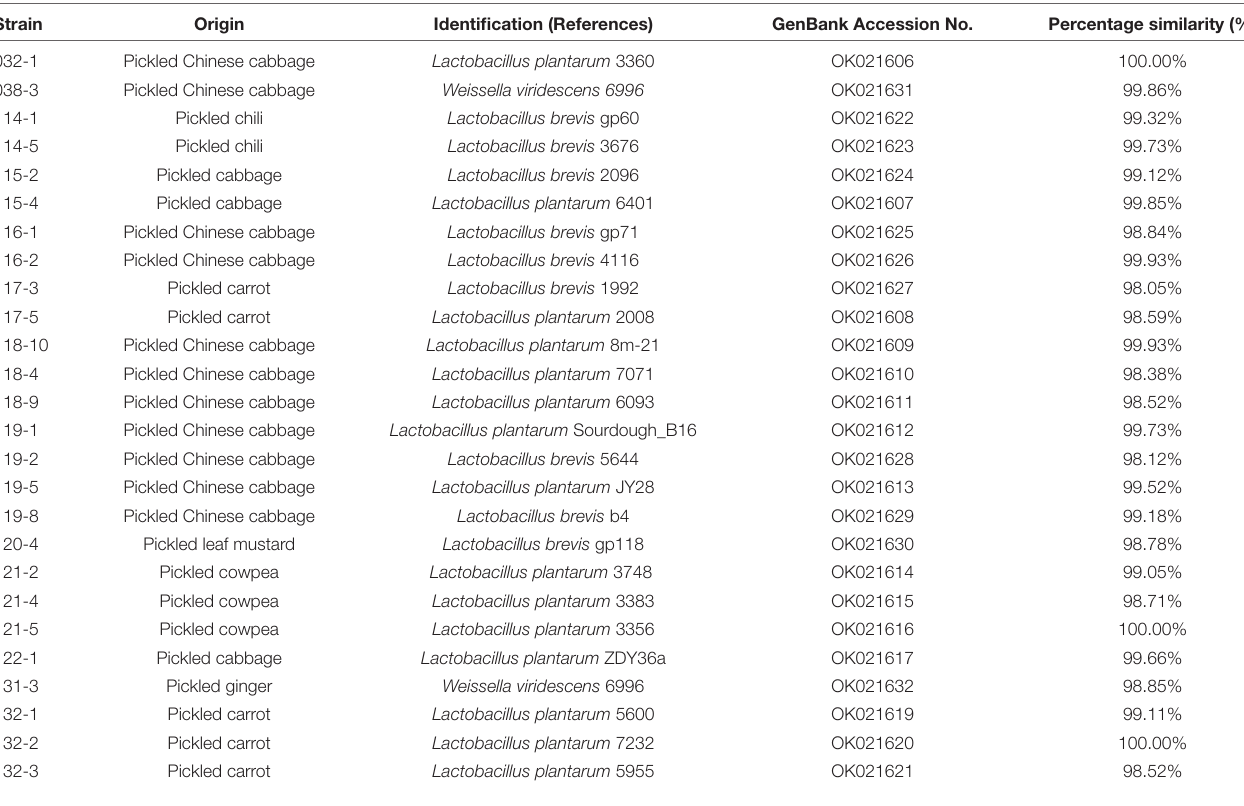
TABLE 1 | Identification of lactic acid bacteria isolated from fermented vegetables in Shaanxi,